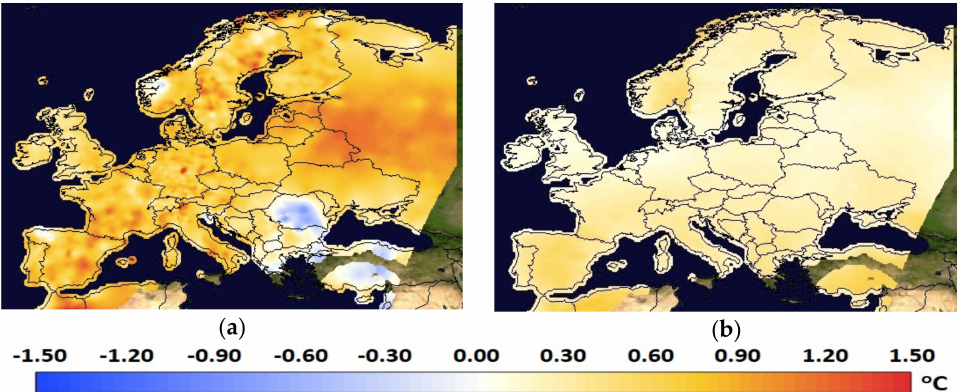
Figure 2. Mean surface temperature change between current (1981–2010) and historic (1951–1980) periods ( a ) Observed (E-OBS) ( b ) Model bias (E-OBS—Model).